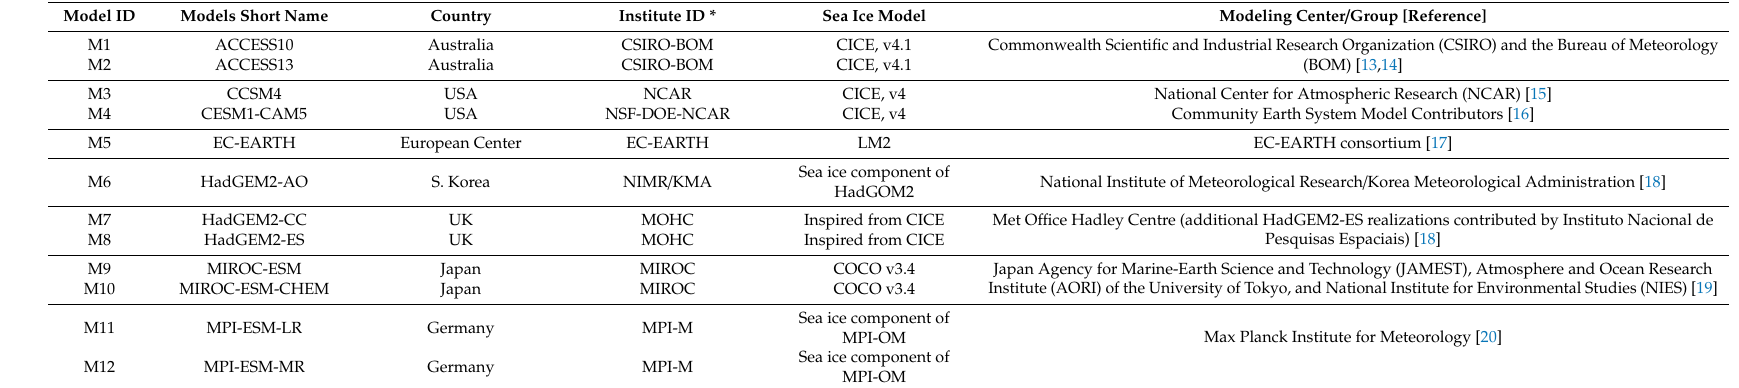
Table 1. A list of models and their attributes (adapted from